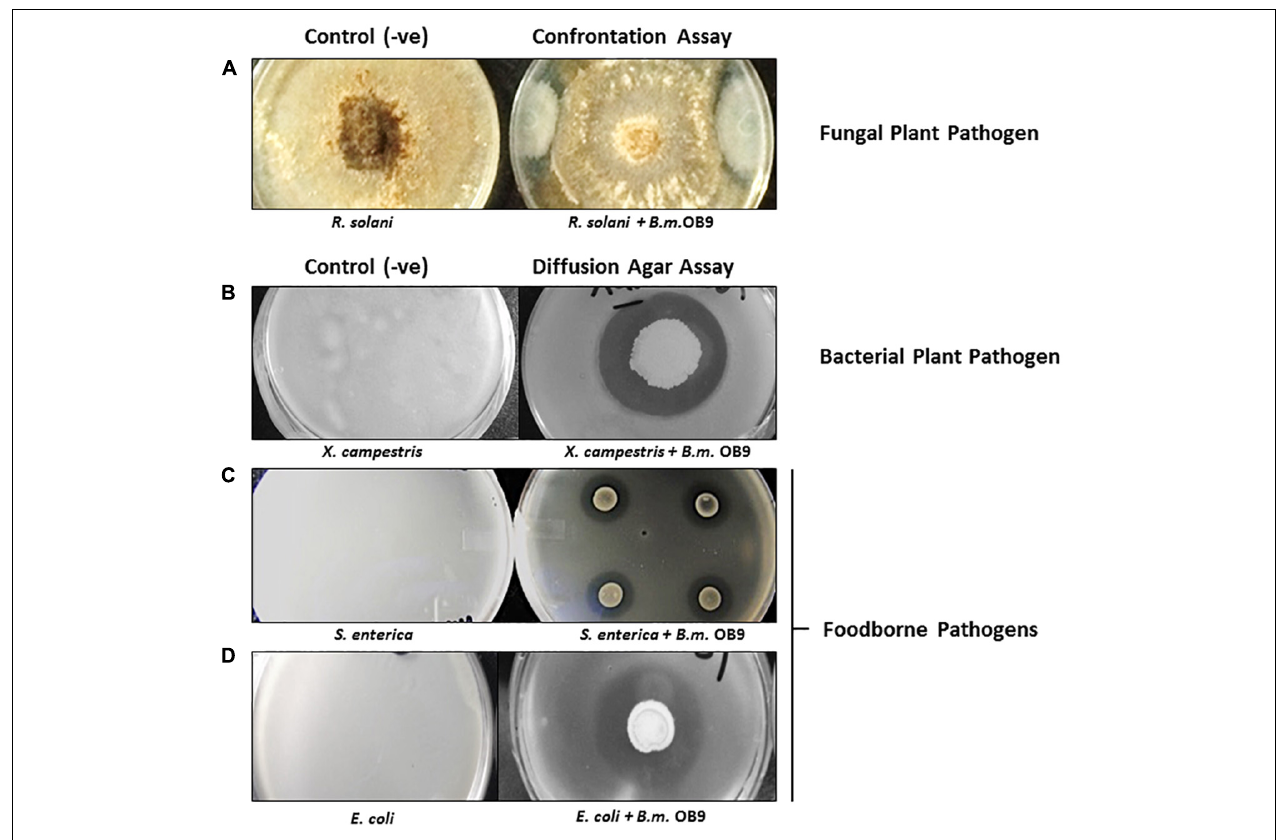
FIGURE 2 | The antimicrobial activities of B. methylotrophicus OB9 ( B.m .OB9) against plant and foodborne pathogens. (A) Confrontation co-culture assay with the fungal plant pathogen, Rhizoctonia solani . (B) Agar diffusion assays with Xanthomonas campestris B07.007. (C) Salmonella enterica Newport SL1. (D)